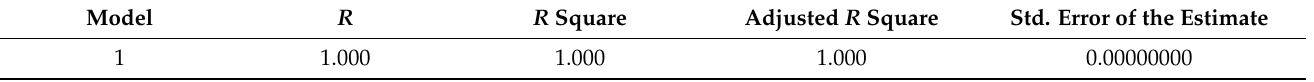
Table 15. Model summary of principal component 1.